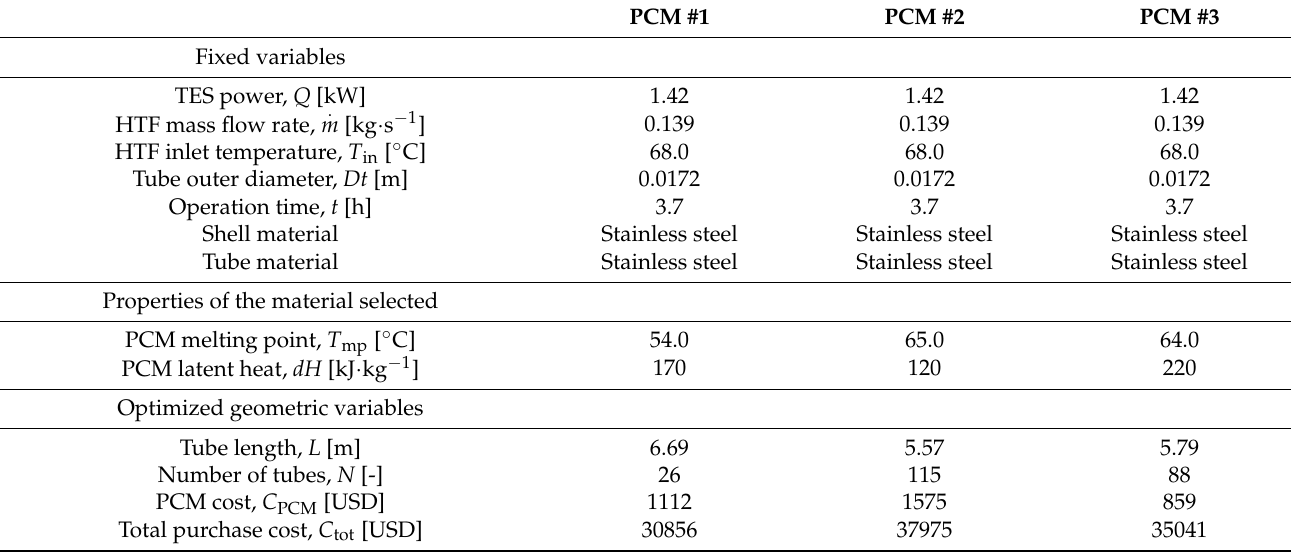
Table 6. Optimized cases for three PCMs with varying tube length and number of